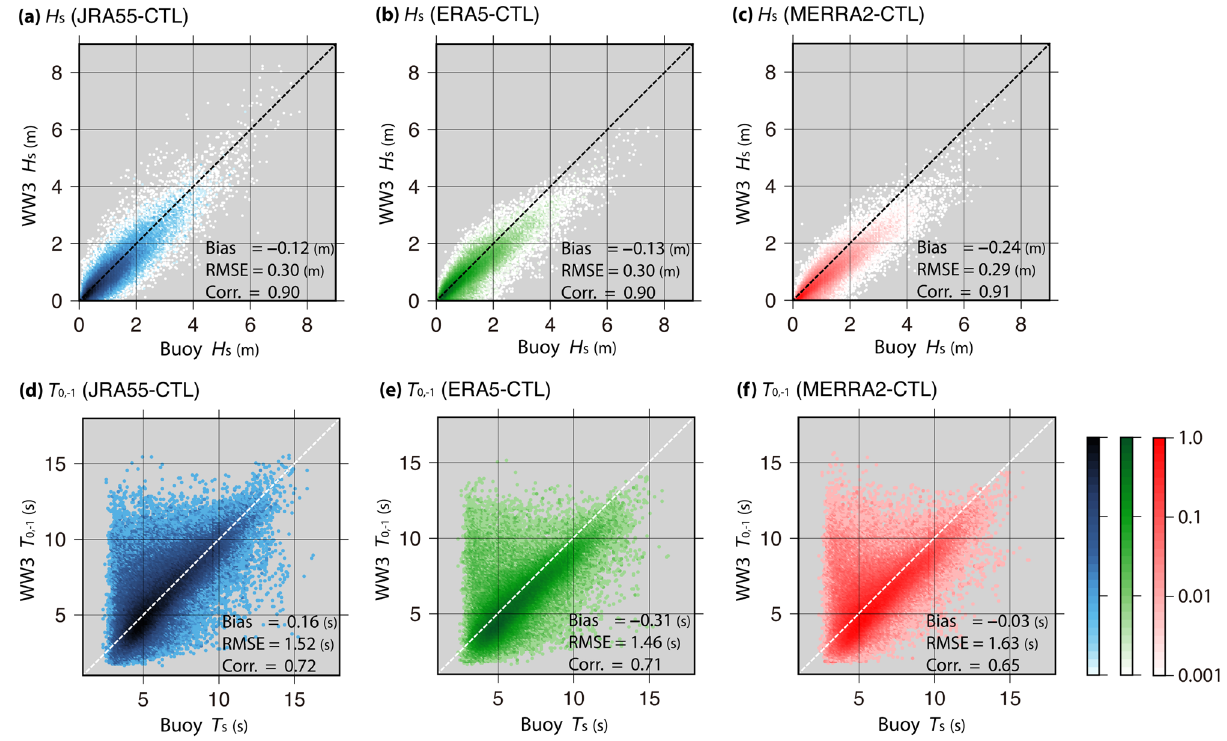
Figure 2. Comparison of (top) H s and (bottom) T 0, − 1 values acquired through buoy observations and model simulations: ( a , d ) JRA55-CTL (blue), ( b , e ) ERA5-CTL (green), and ( c , f ) MERRA2-CTL (red). Color shading indicates normalized data density on a log 10 -scale. The number of validation data points (assessed every 2 h) was 115,188. The black or white broken line y = x was added to each panel. Note that ( a ) and ( d ) present the results published in Iwasaki 15 ; however, the results of the buoy observations conducted in 2020 (Monbetsu south) are included here.